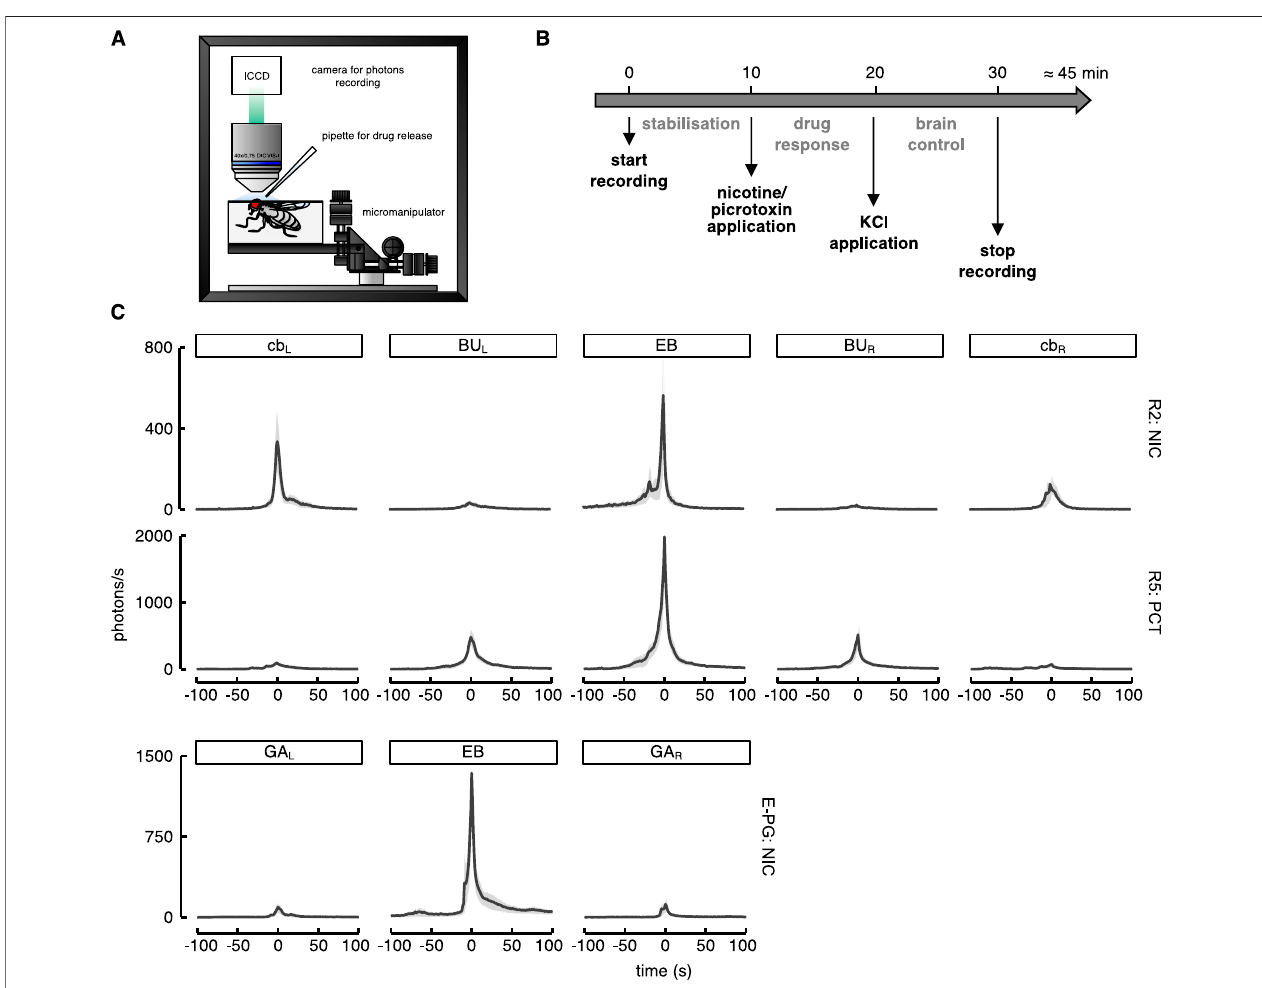
FIGURE 4 | Experimental procedure and Ca 2+ -response to drugs application. (A) Cartoon of the fl y preparation depicting the main components which are not drawn toscale. (B) Schematic drawing ofthe protocol used to stimulate the neurons. (C) Ca 2+ -responsepro fi les todrug application in the selected ROIs (cb L-R : left and rightcellbodies;BU L-R :leftandrightbulb;EB:ellipsoidbody;GA L-R :gallregion).Startingfromthetop:nicotine-evoked(NIC)activityoftheR2neurons(R20D01driver)in the fi veROIsdrawnaroundcb,BUandEB(seealso SupplementaryMovieS1 forarepresentativebrainresponse);inthemiddlepicrotoxin-evoked(PCT)activity of the R5 neurons (R72D06 driver) in the fi ve ROIs drawn as in the previous neurons (see also Supplementary Movie S2 for a representative brain response); at the bottom, nicotine-evoked (NIC) activity of the E-PG neurons (R70G12 driver) in the three ROIs drawn around the 2 GA regions and EB (see also Supplementary Movie S3 for a representative brain